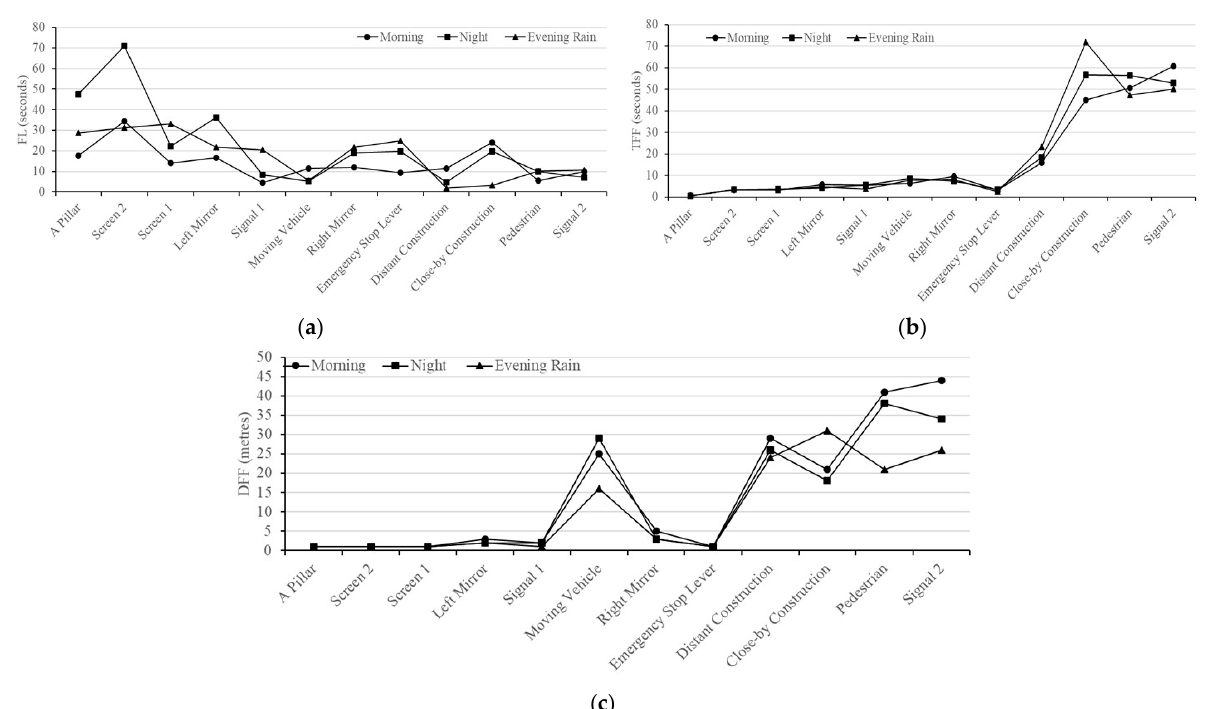
Figure 16. Comparison of Driver 1 responses in terms of ( a ) fixation length, ( b ) time to first fixation and ( c ) distance from first fixation for all scenarios across the three driving conditions.